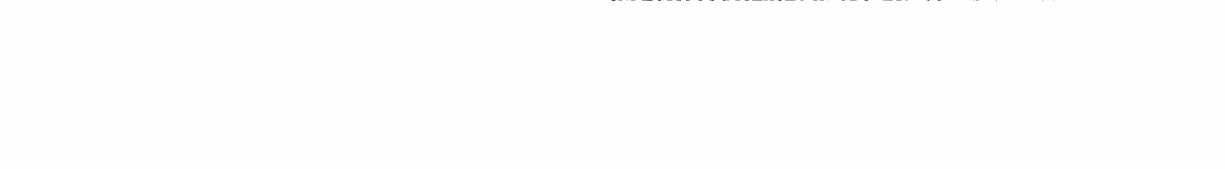
Fig. I. A perspective on labor emphasizing endocrine mechanisms involving the fetal hypothalamic-pituitary- adrenal (HPA) axis and fetal-placental steroidogenesis. In- .creased placental corticotropin releasing hormone (CRH) secretion into the fetal circulation stimulates fetal ACTH production, which, in turn, stimulates cortisol and CI9 an- drogen production (primarily dehydroepiandrosterone sul- fate) by the fetal adrenal. Cortisol completes a positive